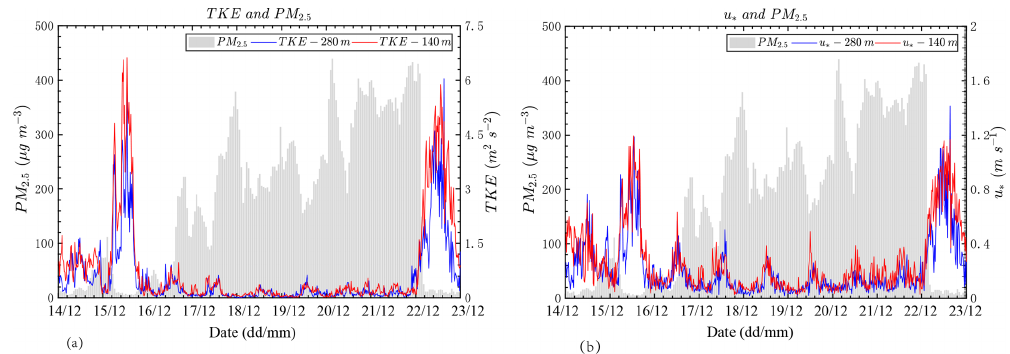
Figure 7. Time series of (a) turbulent kinetic energy (m 2 s − 2 ) and (b) friction velocity ( u ∗ , ms − 1 ) at 140m (red line) and 280m (green line); PM 2 . 5 (µgm − 3 ) concentrations are also shown in the figures (grey columns).